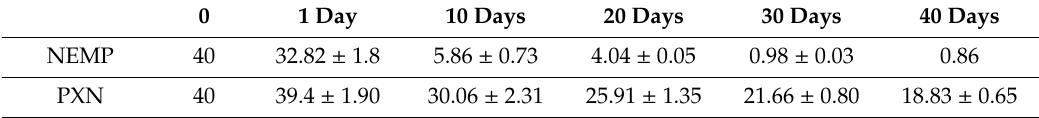
Figure 11. Experimental results to degradation in time of NEMP and PXN in sterile soil sample. Table 6. Values with intervals for 95% of confidence obtained in sterile soil (µmol of OP/kg of soil).